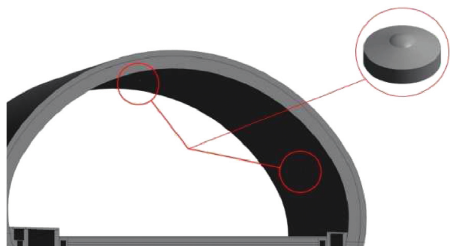
Figure 7: Sensor placement and geometric